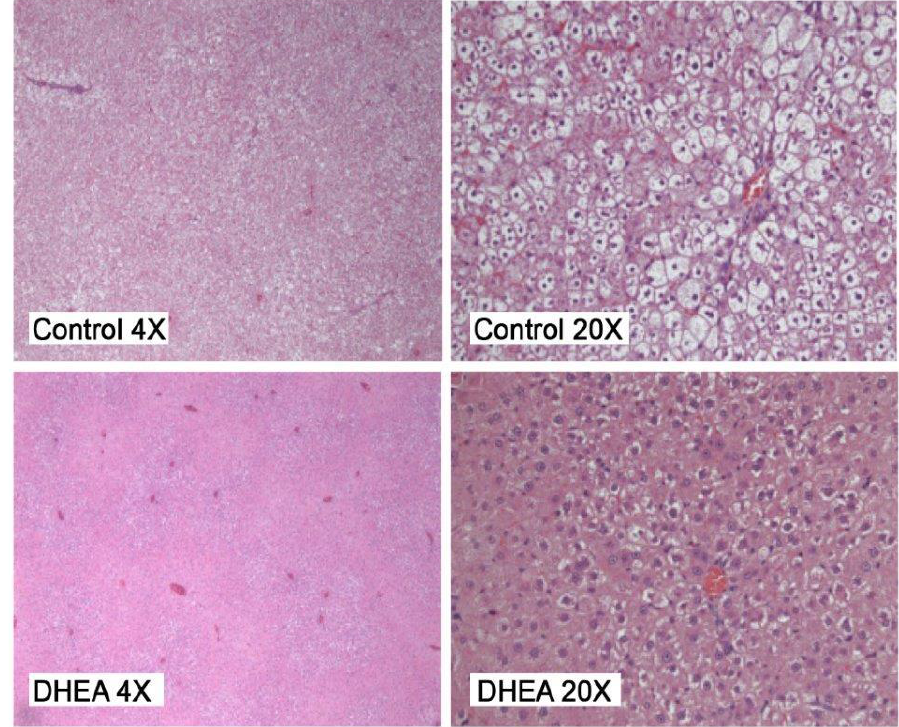
Figure 2. Liver steatosis: obese control shows marked steatosis, original magnification 4 × and 20 × . Obese DHEA shows less steatosis, original magnification 4× and 20×.